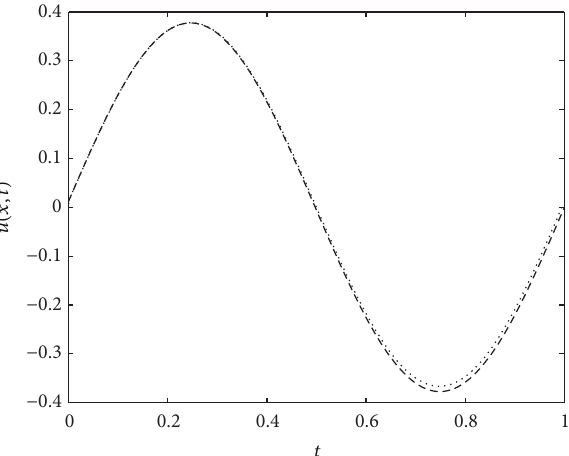
Figure 2: The analytical and numerical solutions of 𝑢(𝑥,𝑡) at the 𝑇 = 1 . The analytical solution is shown with dashed